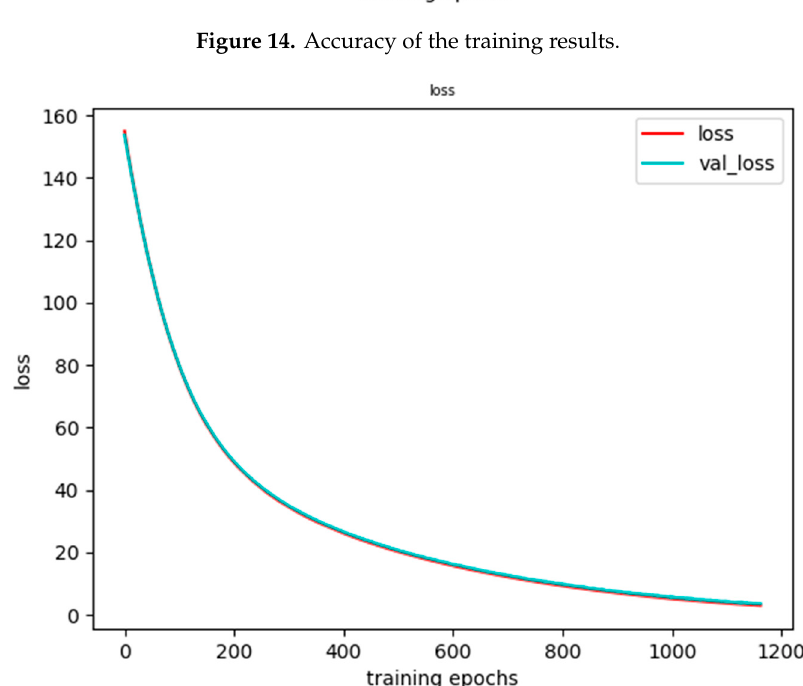
Figure 15. Loss function of the training results.